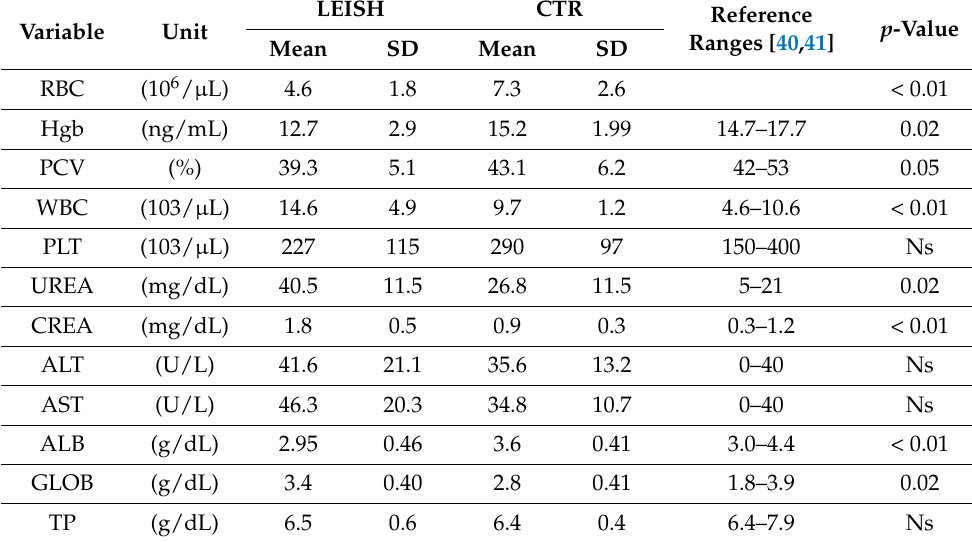
Table 3. Hematological and biochemical variables in dogs affected by CanL (LEISH Group). Variable